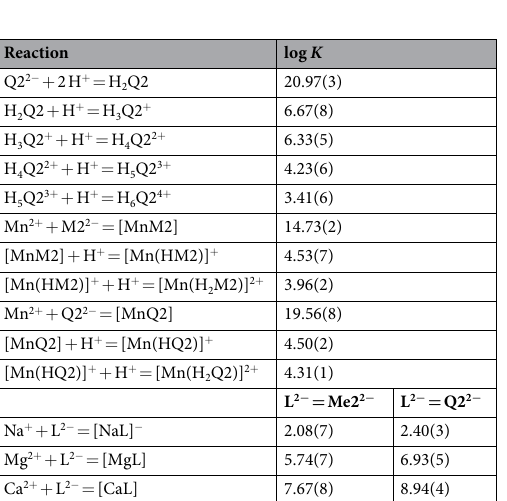
Figure 2. Synthetic procedure used for H 2 Q2 synthesis.